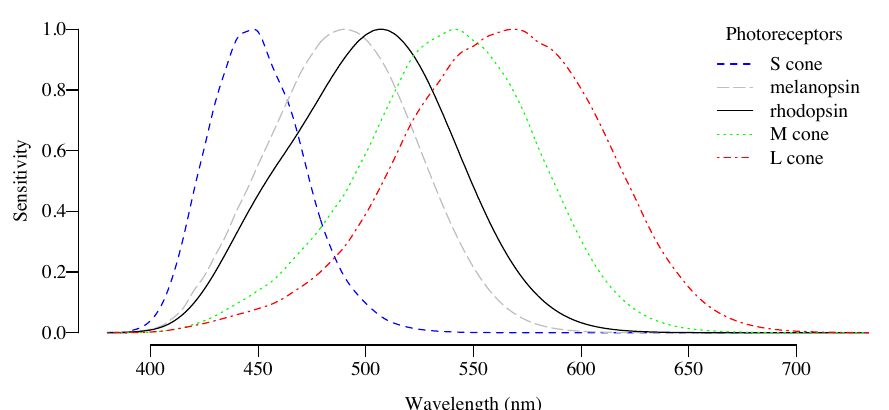
Figure 1. Photoreceptors sensitivity as given by the toolbox of the International Commission on Illumination (CIE)